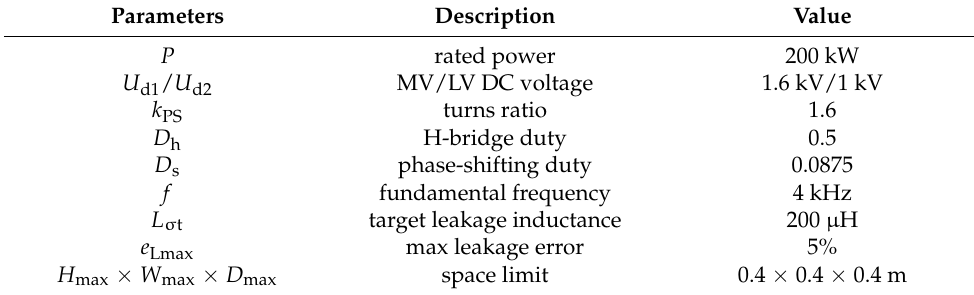
Table 1. Parameters and